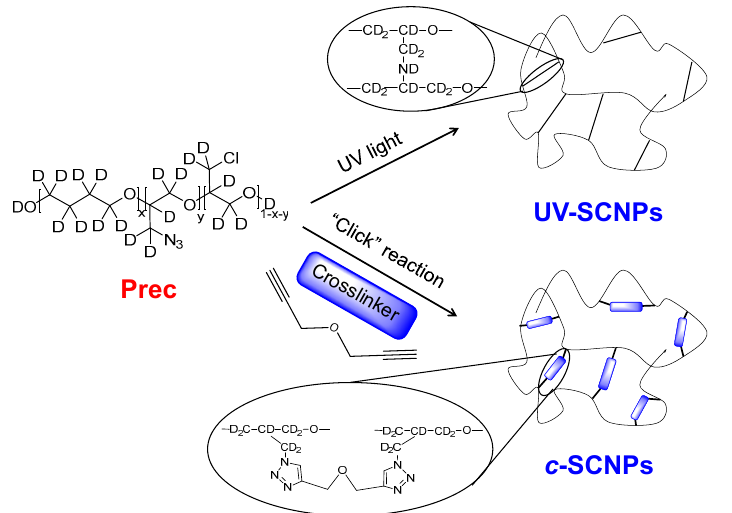
Scheme 1. Schematic representation of the synthesis of SCNPs via intra-molecular azide photodecomposition to give “UV-SCNPs” (Ref. [25] ) and via “click” chemistry using an external homobifunctional cross-linker to produce “ c -SCNPs” (this work).